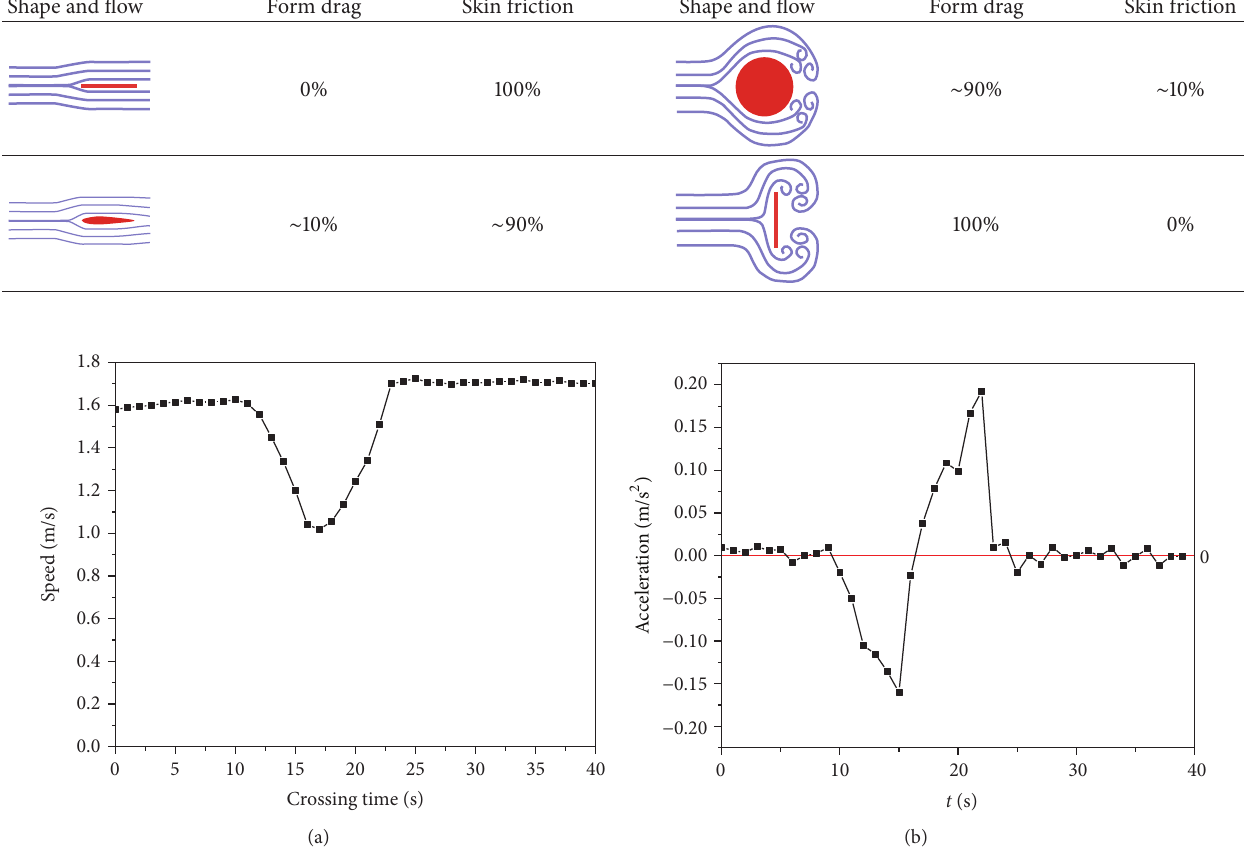
Figure 7: Variation in focal pedestrians’ speed and